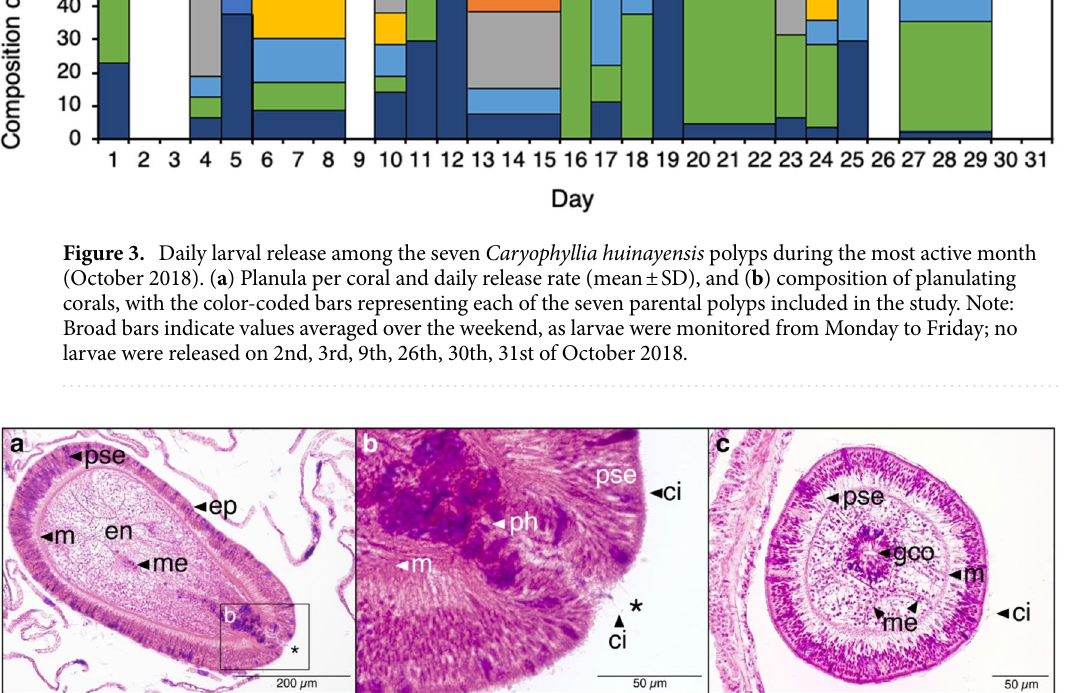
Figure 4. Haematoxylin-eosin-stained longitudinal ( a , b ) and transverse ( c ) histological sections of two larvae inside a polyp of Caryophyllia huinayensis . ( a ) Planula showing the epidermis (ep), the pseudo-stratified epidermis (pse), a thin layer of mesoglea (m), and the endodermis (en). Note that the mesenterial filaments (me) are attached to the pharynx (ph), which in turn is connected to the blastopore/oral pore (*), shown in detain in ( b ). ( b ) Detail from ( a ) showing a ciliated (ci) oral pore connected to the pharynx. ( c ) The gastrovascular cavity opening (gco) and the uniform ciliated epidermis are